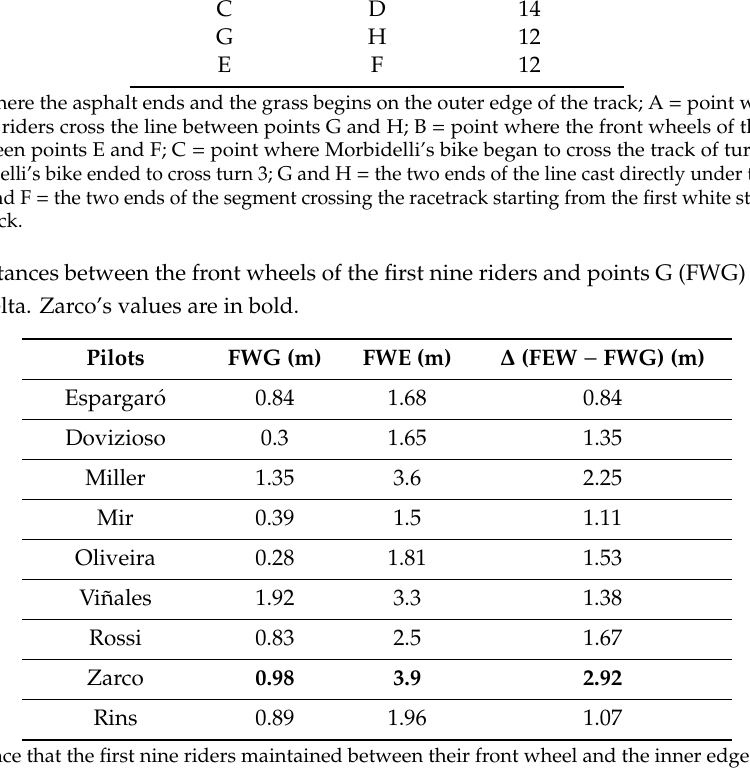
Table 1. Distances between key points on the racetrack. From Point To point Distance (m) A0 A 288 A B 44.5 B C 205.3 C D 14 G H 12 E F 12